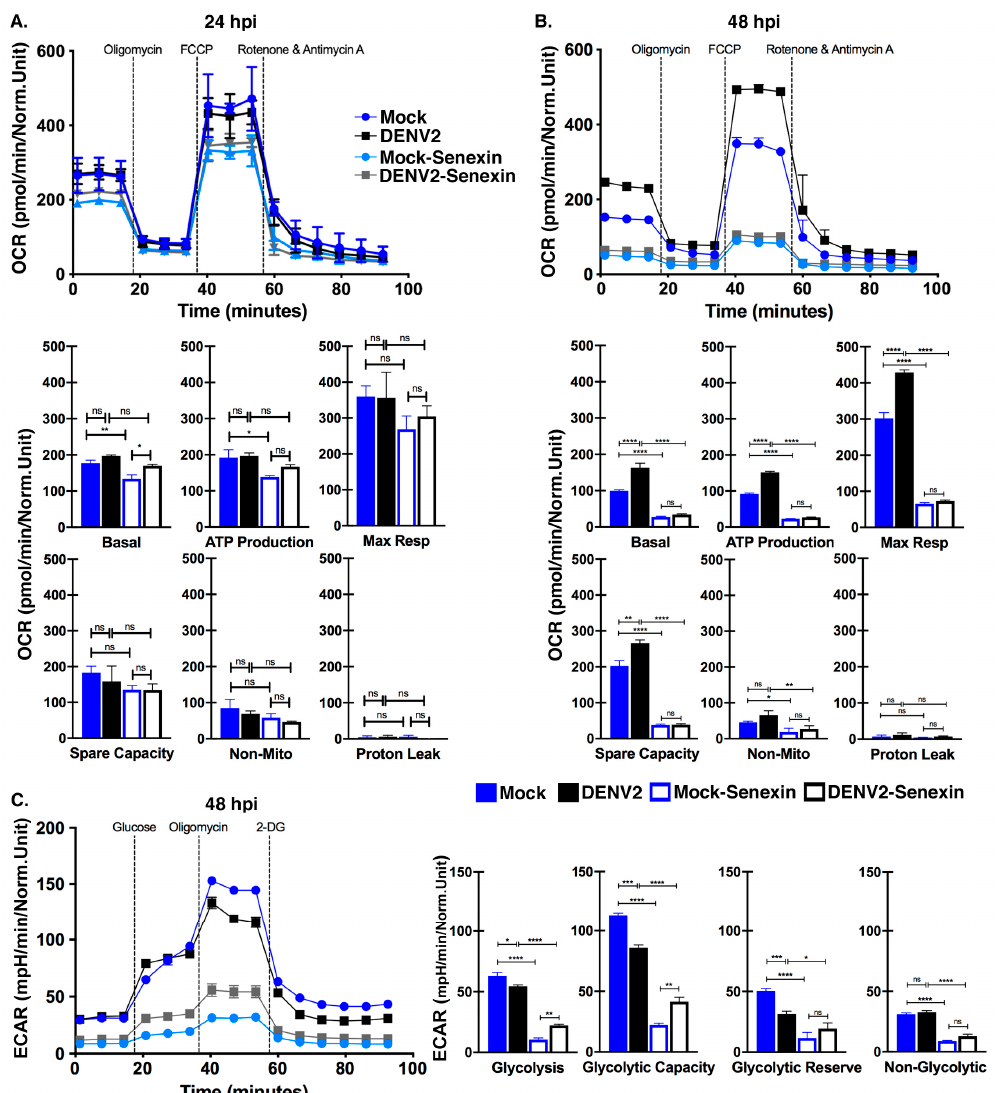
Figure 6. Senexin A inhibits mitochondrial respiration. Huh7 cells were either mock-infected or infected with DENV2 at an MOI of 10 with or without DMSO or 12.5 µM Senexin A for 24 or 48 h. ( A , B ) Normalized oxygen consumption rate (OCR) was measured over time during mitochondrial stress tests. Specific values determined by the mitochondrial stress test (Basal rate, ATP production, Maximum Respiration, Spare Capacity, Proton Leak, and Non-Mitochondrial Respiration) are presented. ( C ) Normalized extracellular acidification rate (ECAR) was measured over time during a glucose stress test at 48 hpi. Specific values determined in the glucose stress test (Glycolysis levels, Glycolytic Capacity, Glycolytic Reserve, and Non-Glycolytic Capacity) are presented. Results were normalized to viable cell numbers after metabolic measurements. Parameters for individual measurements are presented in the methods (* p < 0.05, ** p < 0.01, *** p < 0.001, **** p < 0.0001 one-way ANOVA with Tukey’s multiple comparisons test. n = 3 biological replicates). Error bars represent mean +/SEM.